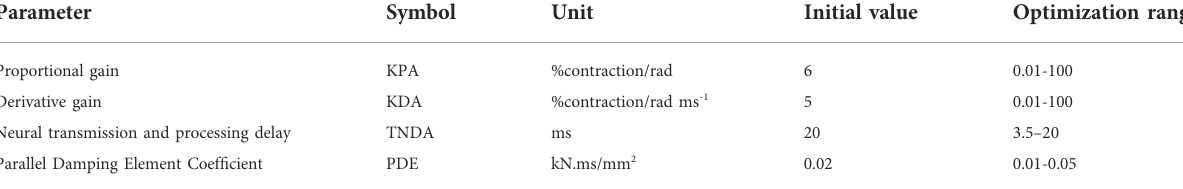
TABLE 1 Optimization